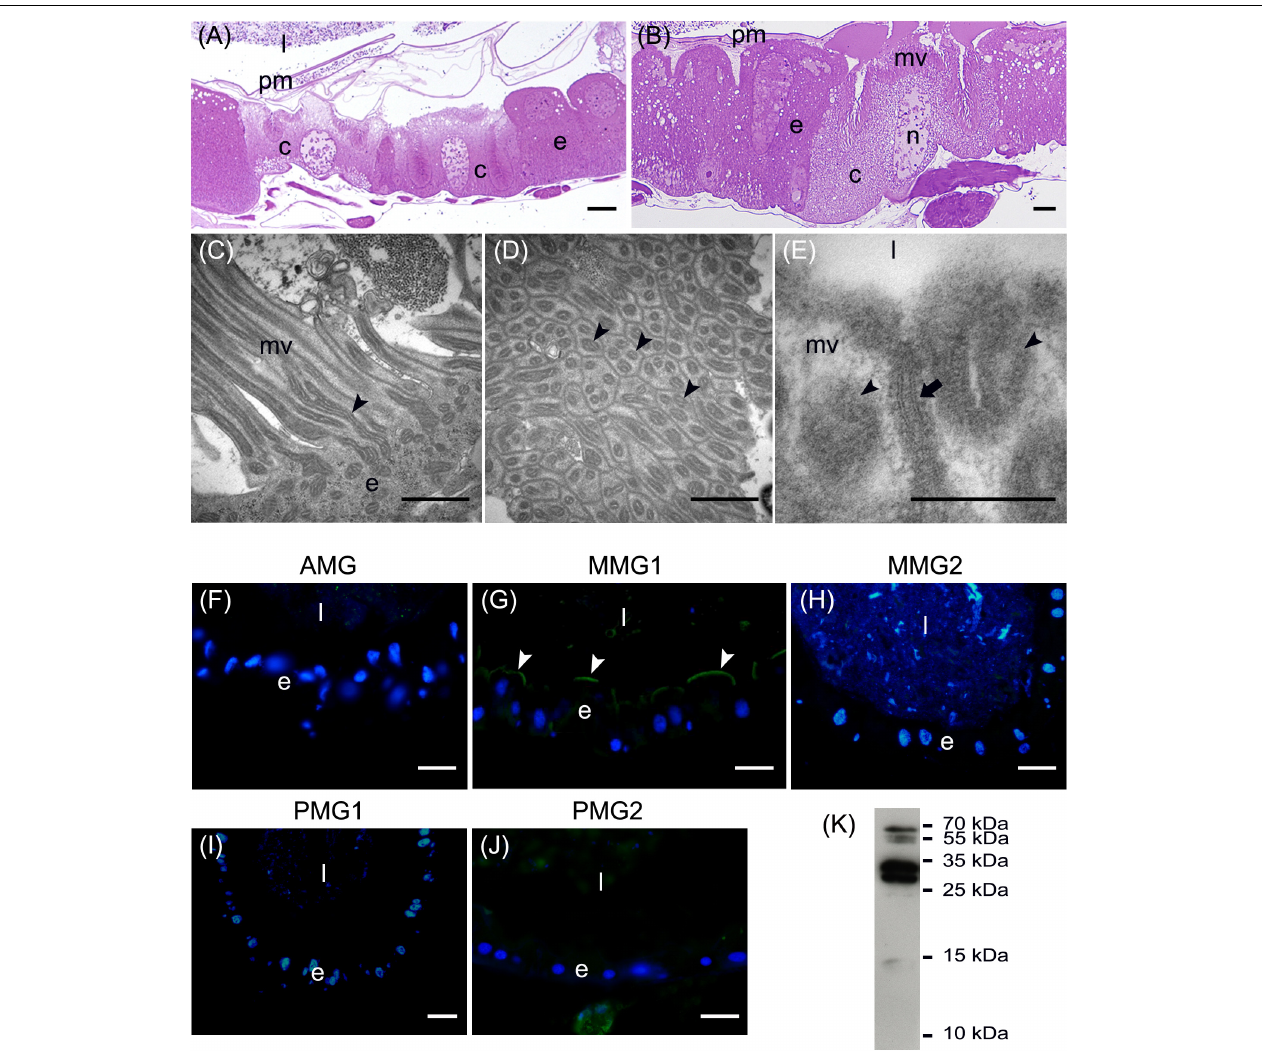
FIGURE 4 | Morphological organization of MMG1. (A,B) Copper cells (c) characterized by the long microvilli (mv). (C,D) Elongated mitochondria (arrowheads) are visible in longitudinal (C) and cross (D) section of microvilli (mv). (E) Portasome-like structure (arrow) in the apical surface of microvilli. Mitochondria (arrowheads) are visible. (F–J) H + V-ATPase immunolocalization (white arrowheads) in the different midgut regions. (K) Western blot analysis of H + V-ATPase. e: epithelium; l: lumen; n: nucleus; pm: peritrophic matrix. Bars: 20 µ m (A,G–K) , 10 µ m (B) , 1 µ m (C,D) , 200 nm (E)